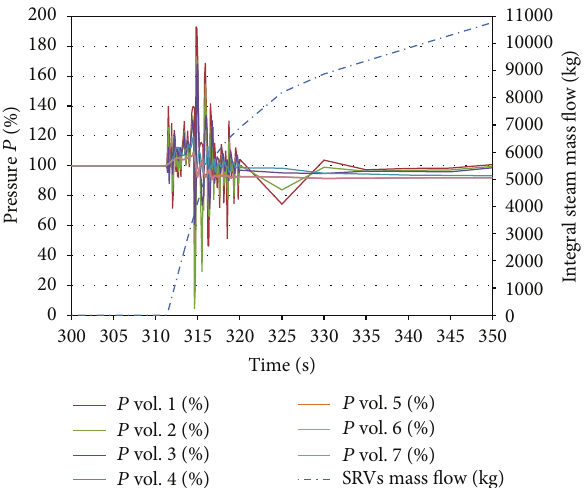
Figure 4: Pressure evolution in the volumes that compose the containment and integral steam mass flow towards the PSP, during the first 40 seconds of the LOOP.